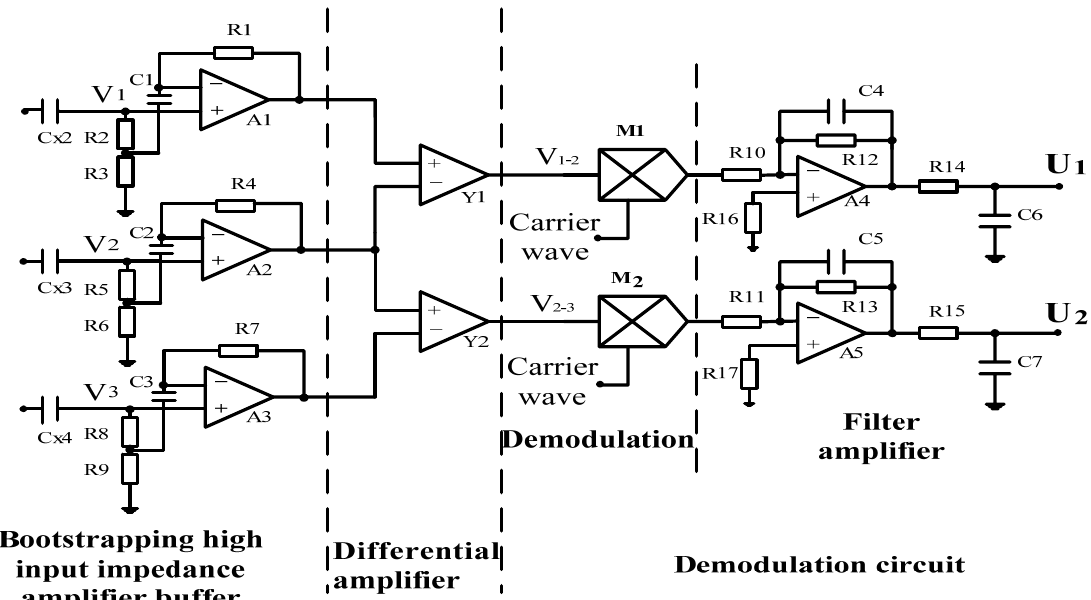
Figure 3. The signal processing